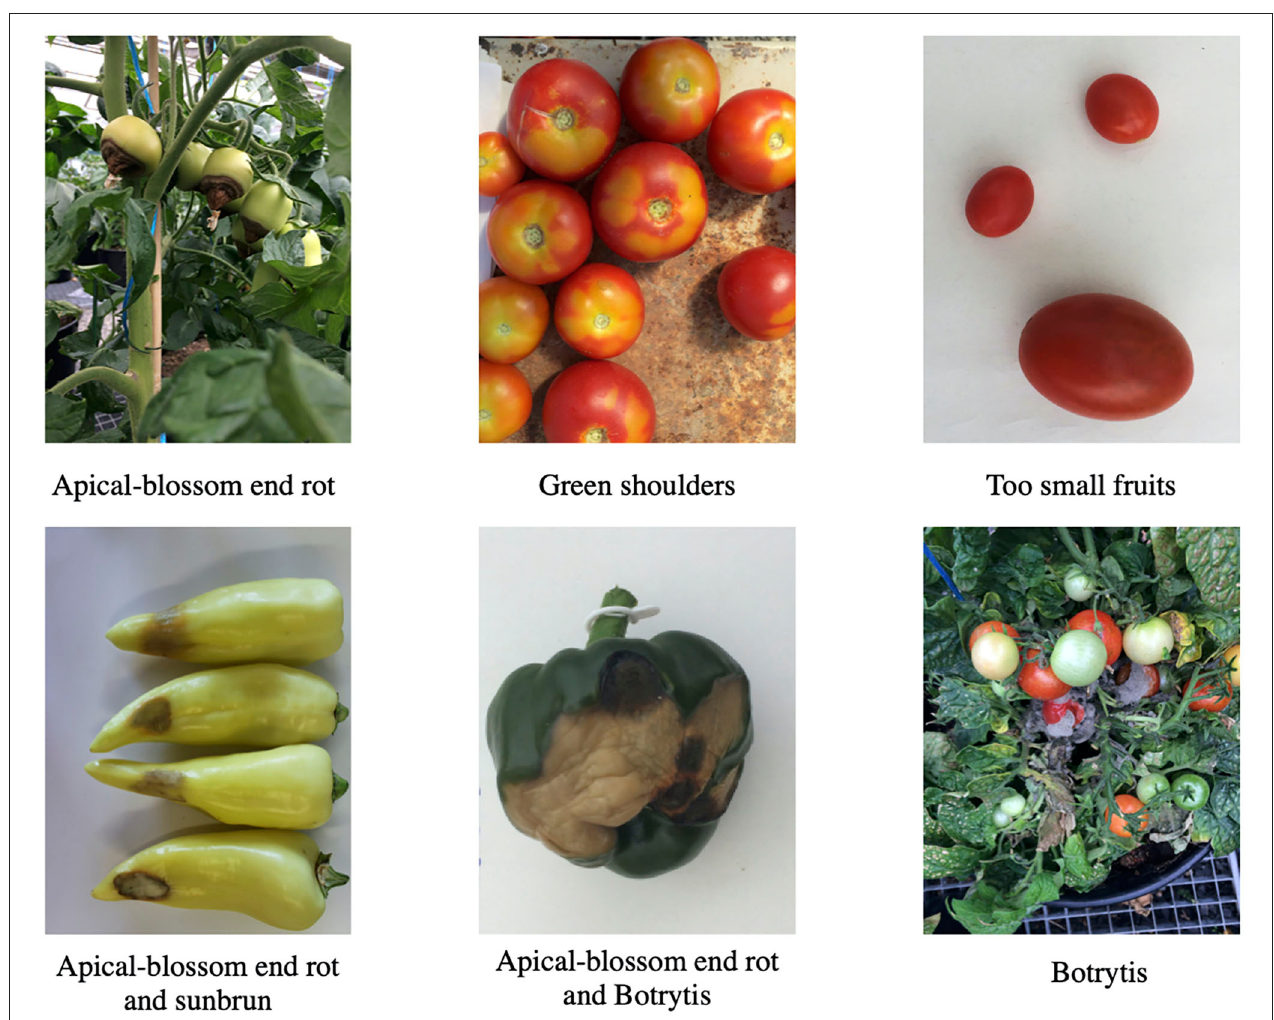
FIGURE 2 | Selection of deficiency symptoms recorded on tomato and sweet pepper fruits. Affected fruits were categorized into commercial class 2 (green shoulders, too small fruits) or minus (botrytis, apical-blossom end rot). Symptoms were detected equally on hybrid, organic, and conventional